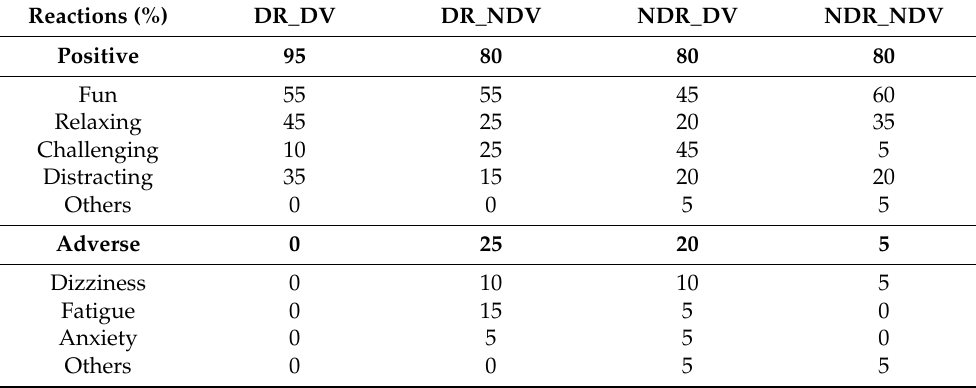
Table 2. Percentage of participants with positive and adverse reactions after each experimental condition. The percentage of participants per specific reaction is also